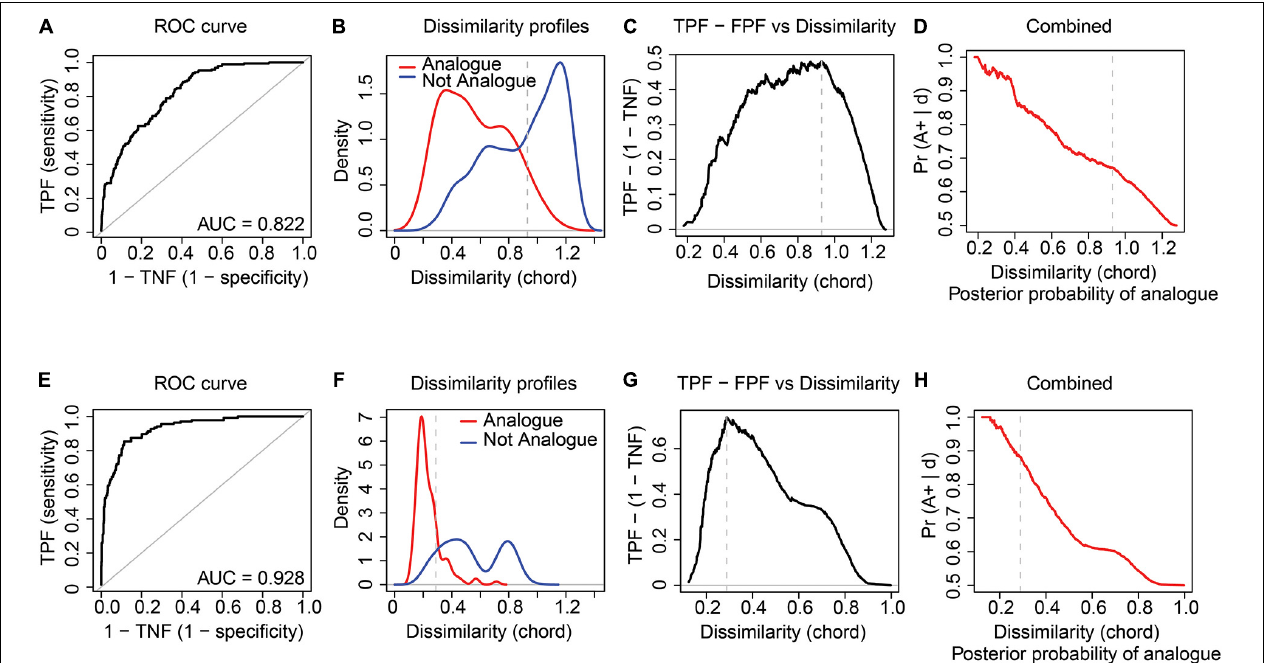
FIGURE 2 | Receiver operating characteristic (ROC) curve analysis with chord distance applied to the log(x + 1) transformed modern sedDNA and modern pollen data for Lake Naleng. The results demonstrate that vegetation types can be well discriminated based on modern sedDNA (A–D) and pollen assemblages (E–H) . The ROC curve and the area under curve (AUC) value assess the optimal dissimilarity threshold ( d crit ) (A,E) . Dissimilarity curves show the kernel density estimates of the distribution of pair-wise dissimilarities for analogue and non-analogue samples (B,F) . The sensitivity (true positive fraction: TPF) and the specificity (true negative fraction: TNF) against dissimilarity suggest a good performance of ROC curve analysis (C,G) . The posterior probability that any two samples are analogues is calculated based on TPF and FPF (D,H) . Vertical dashed lines mark d crit . All curves show the results of the combined vegetation types.